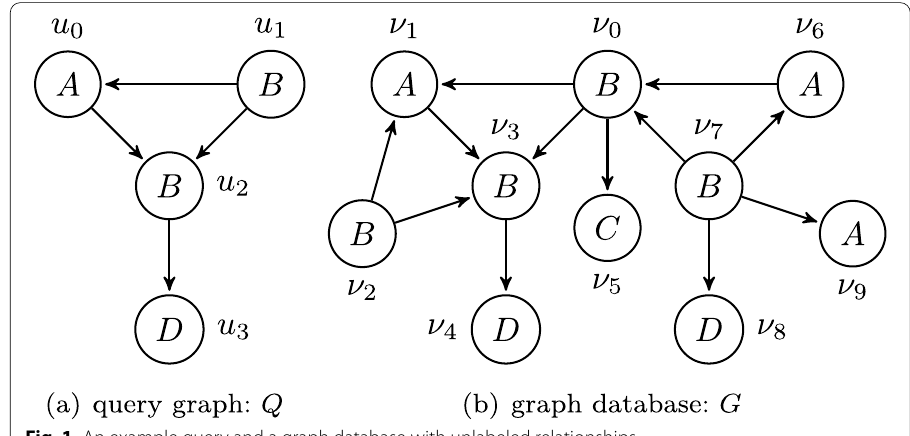
Fig. 1 An example query and a graph database with unlabeled